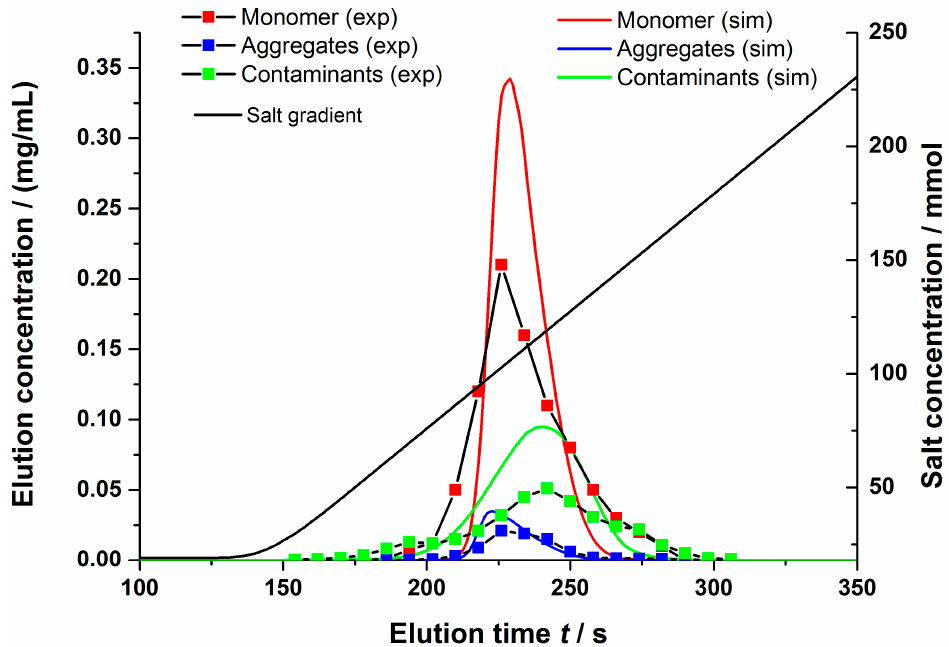
Figure 12. Comparision between the measured and simulated signals reagarding the main components for a bind and elute experiment using clarified cell culture broth. Binding and wash buffer: 10 mM KPi, pH = 6, 20 mM NaCl; elution buffer: 10 mM KPi, pH = 6, 500 mM NaCl; 10 CVs gradient duration; flow rate: 3 mL/min.